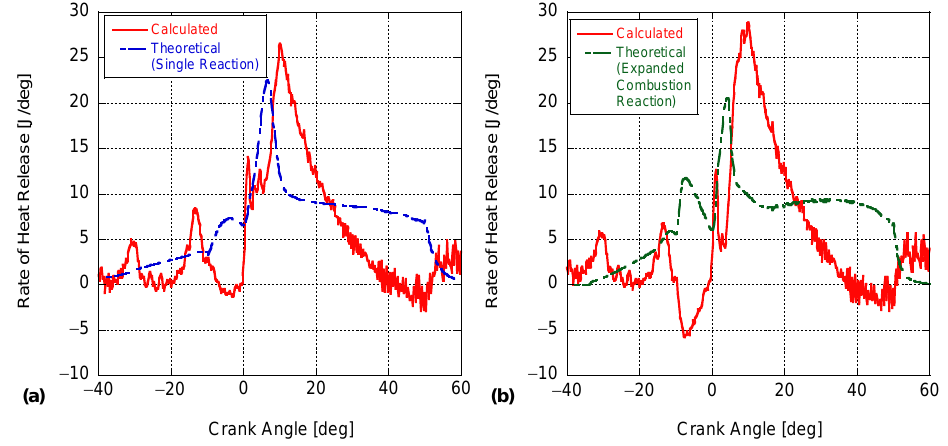
Figure 6. The calculated rate of heat release according to the conservation of energy and the theoretical heat release based on the change in chemical species of Equation (67). ( a ) Single combustion reaction of Section 2.2 and ( b ) expanded combustion reaction after optimization.